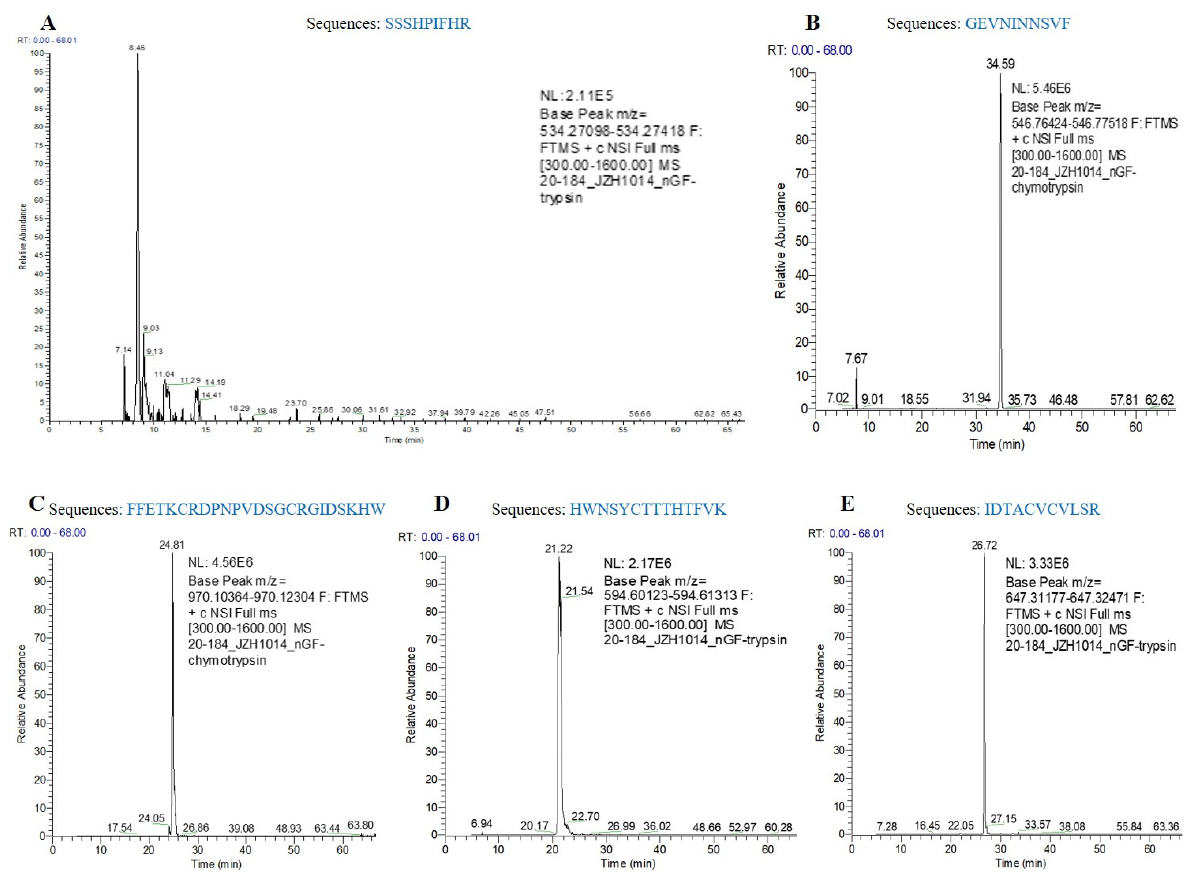
Figure 5. The mass spectrograms of amino acid sequence analysis of purified hNGF. ( A – E ) are mass spectrograms of analysis of five different short peptides generated by trypsin digestion of purified hNGF.